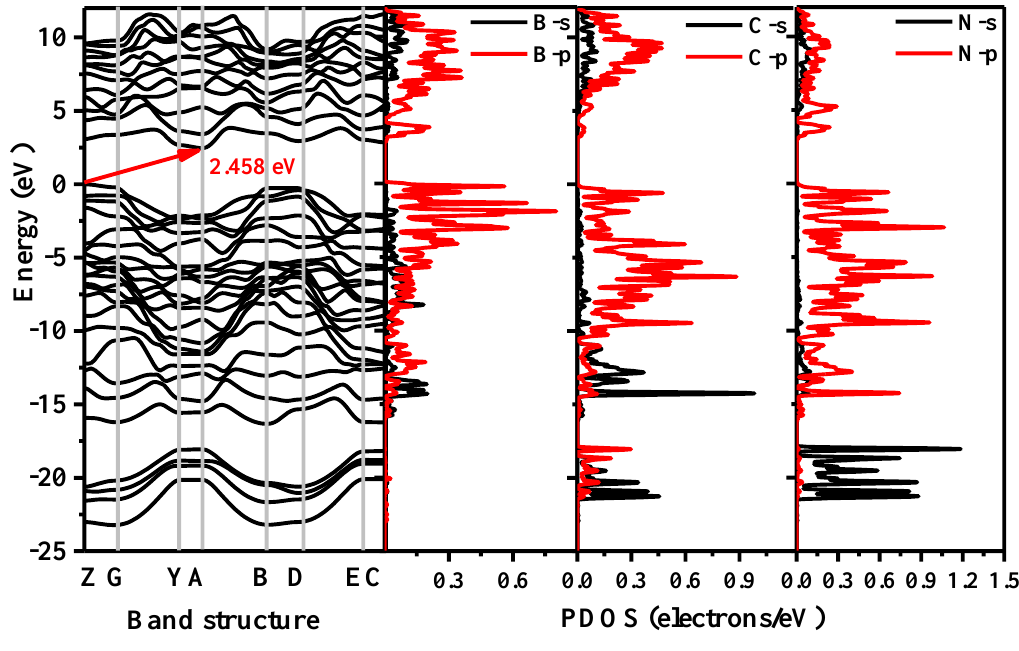
Figure 5. Band structure and the partial density of states (PDOS) of Pm -BCN.